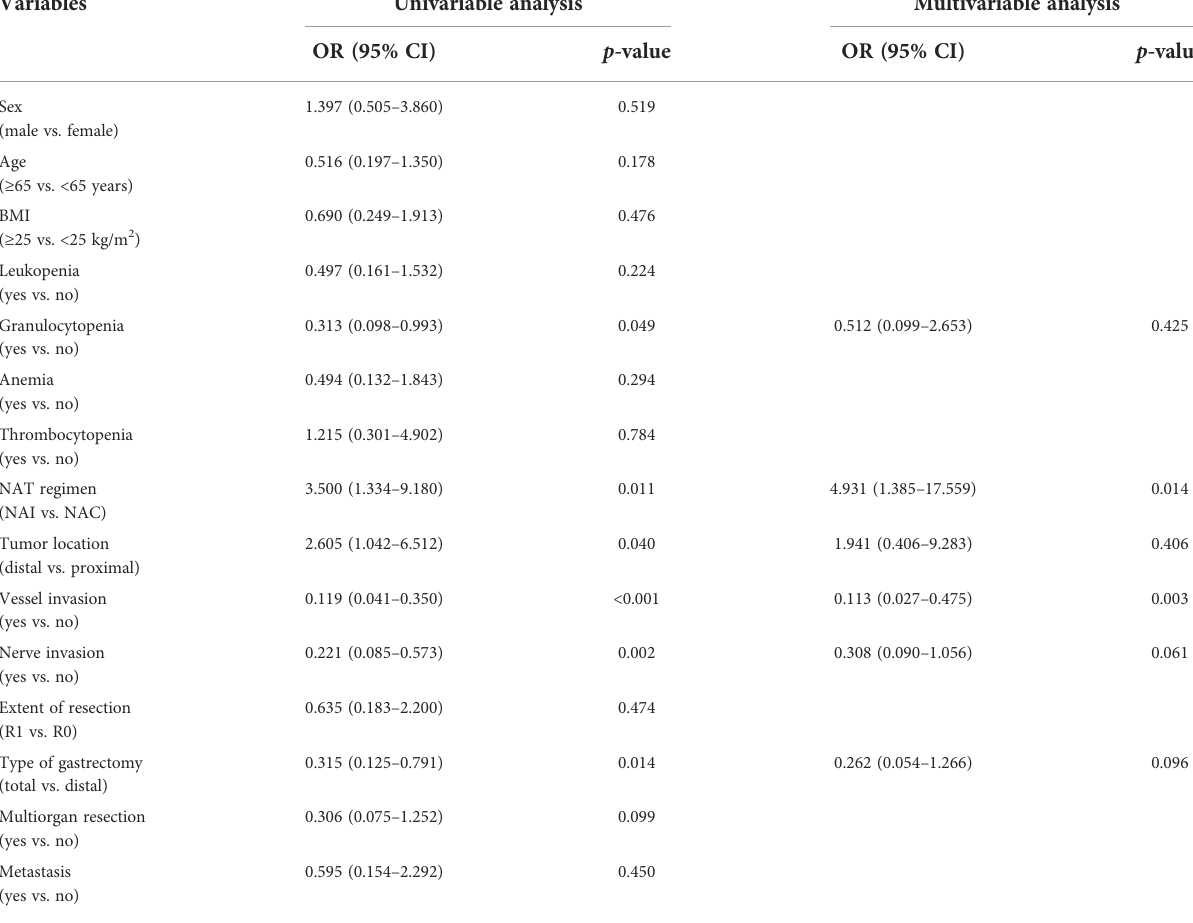
TABLE 5 Multivariable regression analysis of risk factors for the overall response rate in all